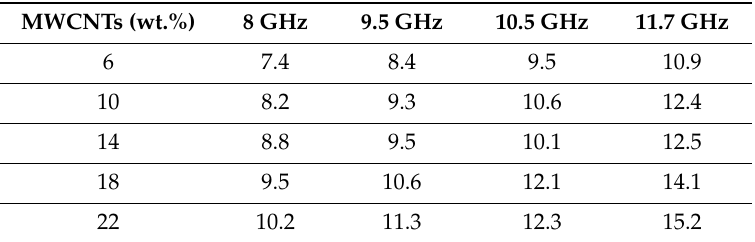
Figure 8. Variation in absorption loss for the OPEFB / PLA / MWCNT nanocomposites. Table 2. Variation in absorption loss ( SE A ) for the OPEFB / PLA / MWCNTs composites. MWCNTs (wt.%) 8